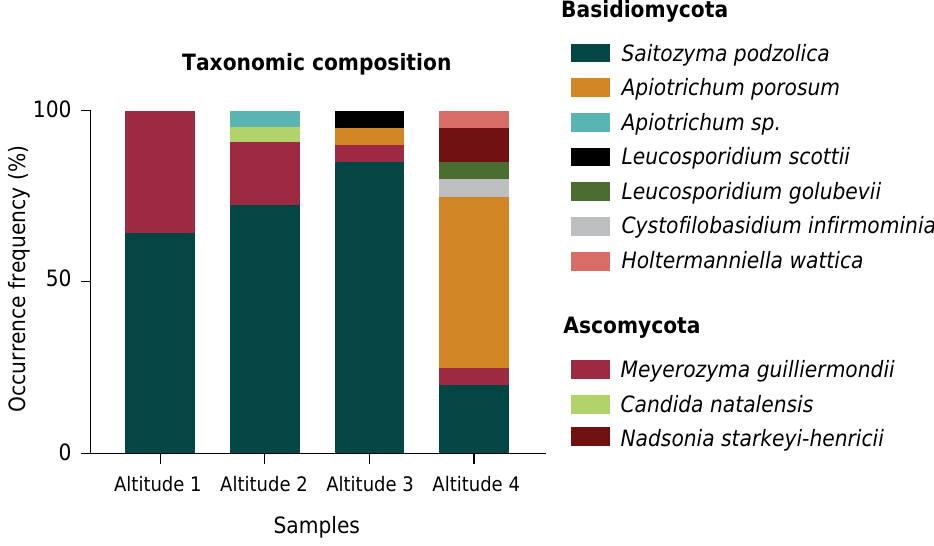
Figure 2. Taxonomic composition of soil yeast species obtained at four altitudes (404; 1,016; 1,658; and 2,124 m) in the